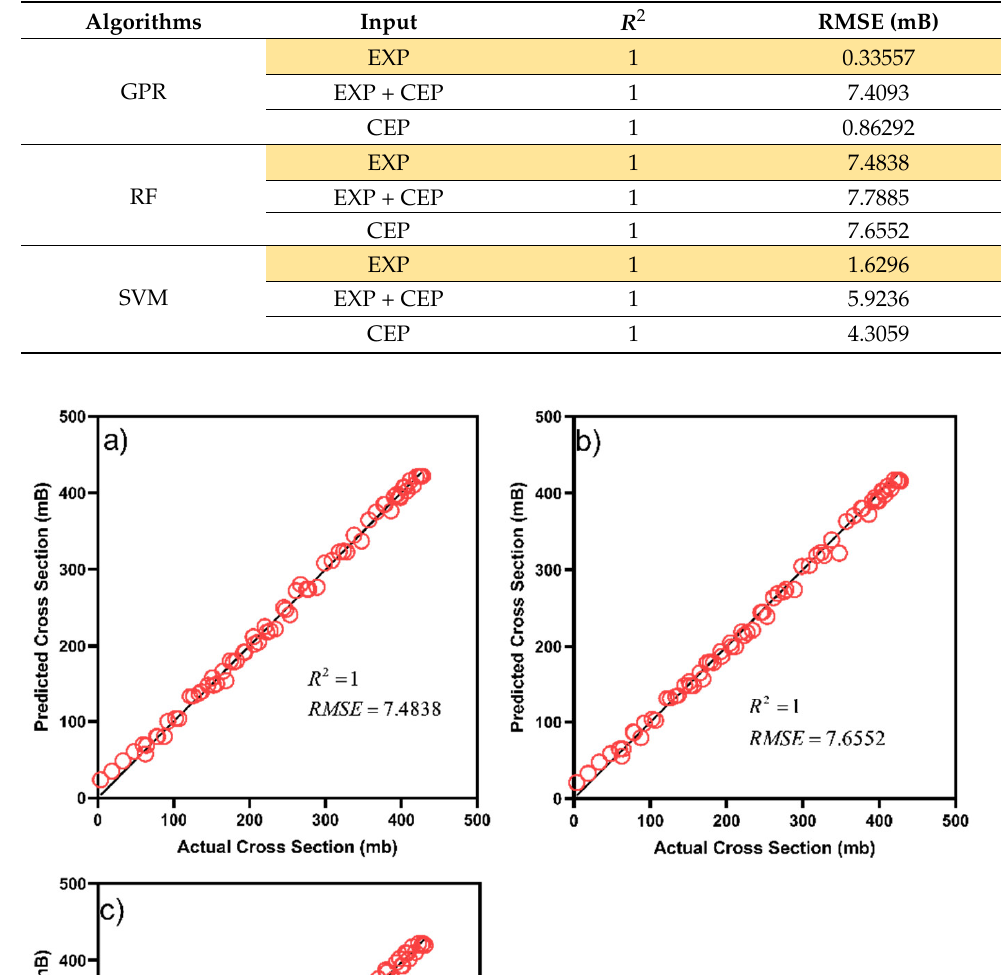
Table 3. The statistical analysis of the performance of GPR, RF, and SVM algorithms using EXP, EXP + CEP and CEP input. The machine learning model with R 2 closed to 1 and lowest RMSE is highlighted in yellow.